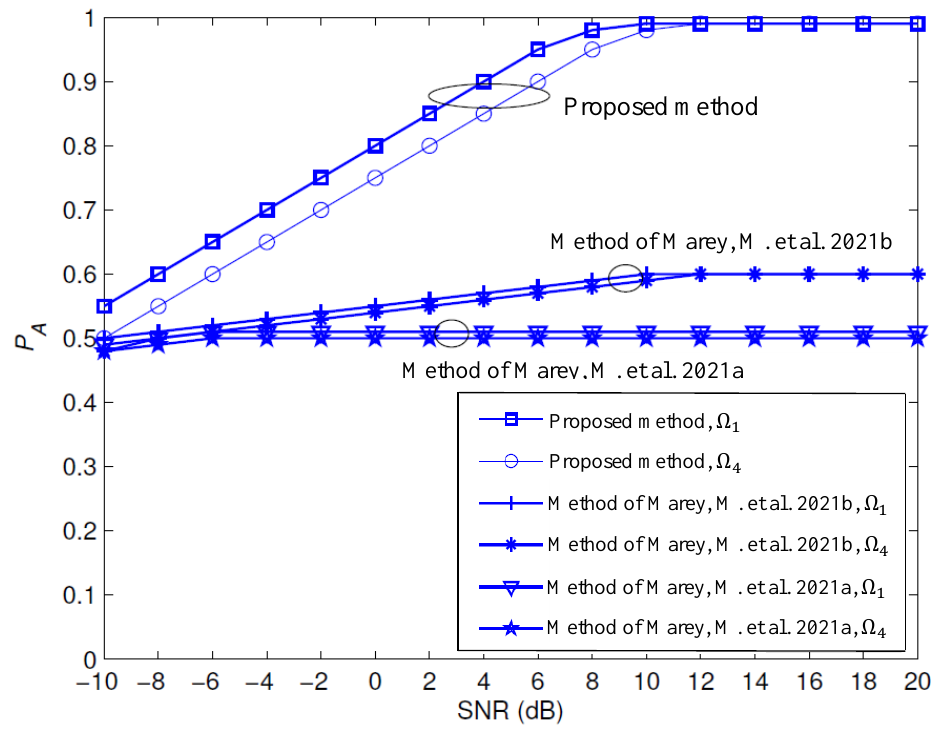
Figure 20. The performance of the proposed method in comparison to previous works for the modulation sets of Ω 1 and Ω 4